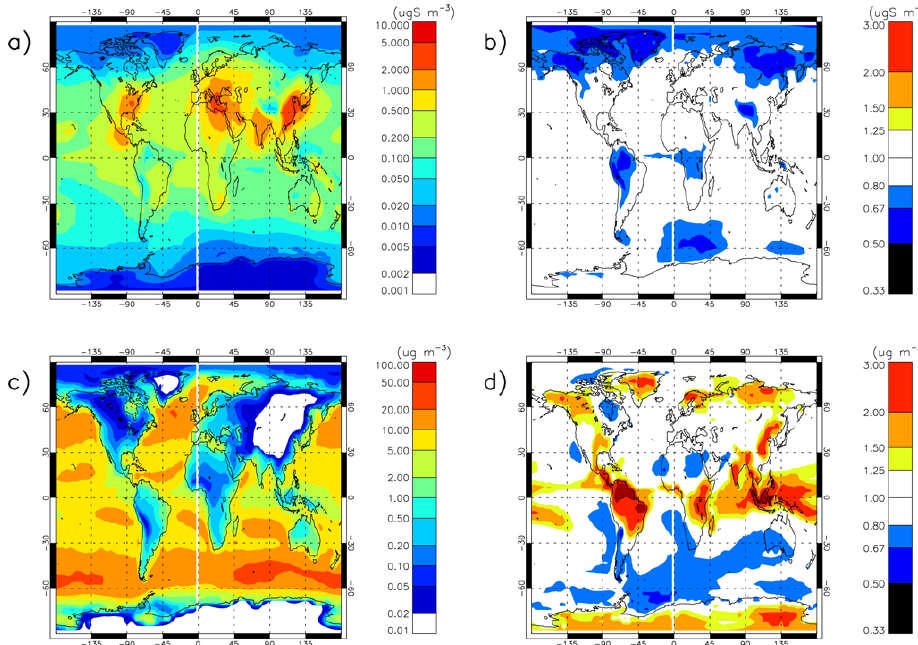
Fig. 5. Global surface maps showing (a) sulphate (SO 4 ) and (c) sea-salt (NaCl) aerosol mass simulated by GLOMAP-mode (v6R) on the annual-mean. The ratio of GLOMAP-mode (v6R) to GLOMAP-bin simulated SO 4 and NaCl are shown in panels (b, d) , respectively. Regions coloured yellow, orange and red in the relative bias maps indicate where GLOMAP-mode is higher than bin by 25–50, 50–100 and 100–200%, respectively, whilst light-blue, dark-blue and black indicate where bin is higher by the same proportions. Regions where the two schemes are within 25% are colored white.